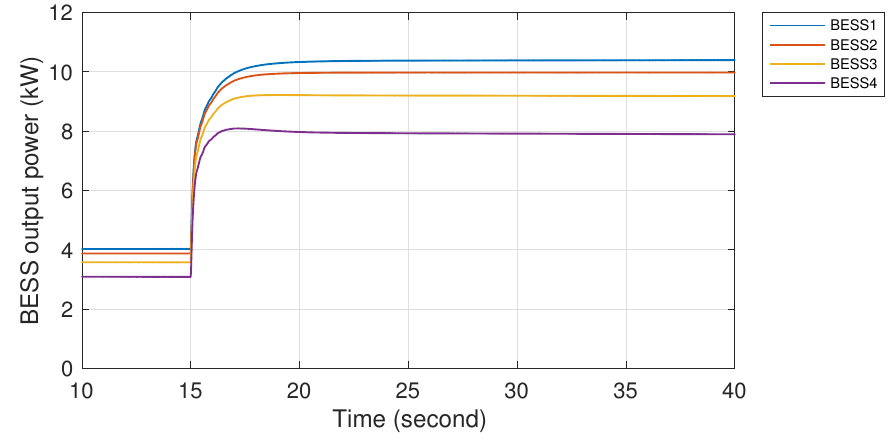
Figure 10. BESSs’ active powers.